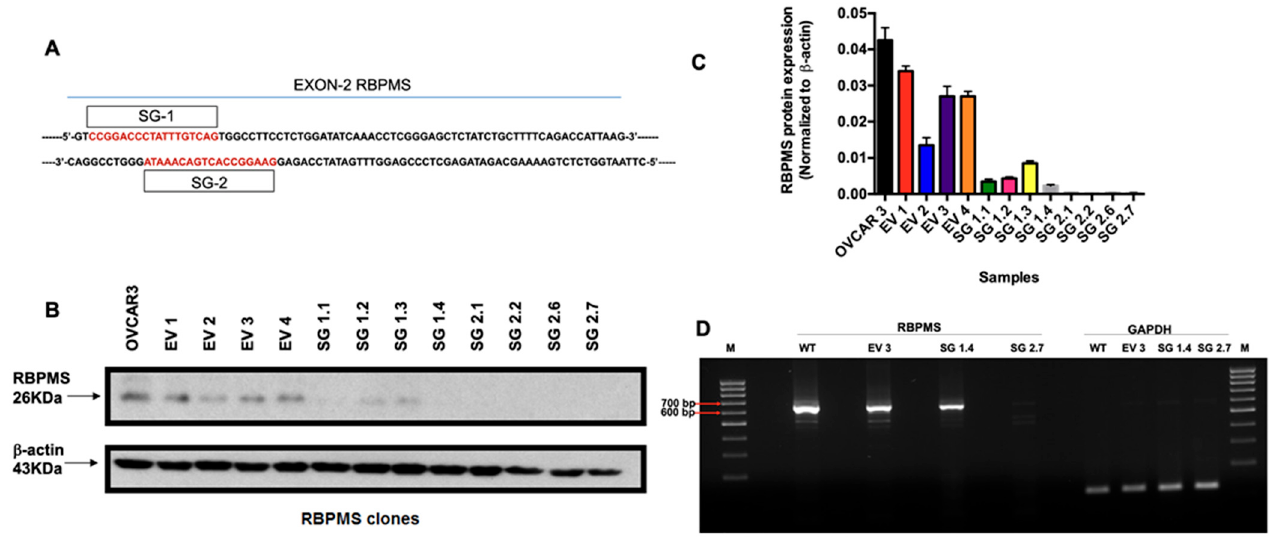
Figure 2. CRISPR-mediated RBPMS clone generation and validation: ( A ) RBPMS gene segment showing the sites targeted by the single guide 1 and single guide 2 (SG1 and SG2) RNAs. ( B , C ) Western blot and densitometric analysis of the intensity bands, normalized to OVCAR 3. ( D ) RT-PCR of SG1.4 and SG2.7 clones. GAPDH used as a loading control.